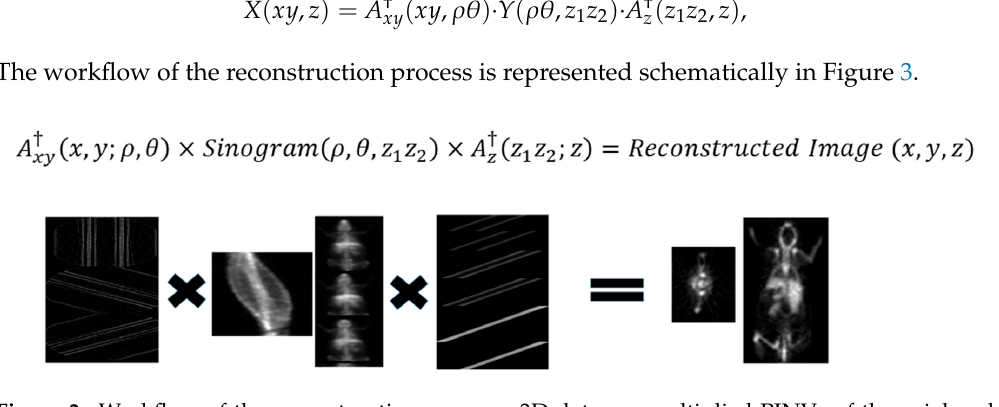
Figure 2. Singular values of a small matrix (solid line) and its reciprocals using different regularization methods. Tikhonov ( k = 0.01) and Landweber ( n = 100) regularization for equivalent iterations. Truncated singular values (TSVD) with a threshold of 0.1 and original singular values (SV) are also shown.